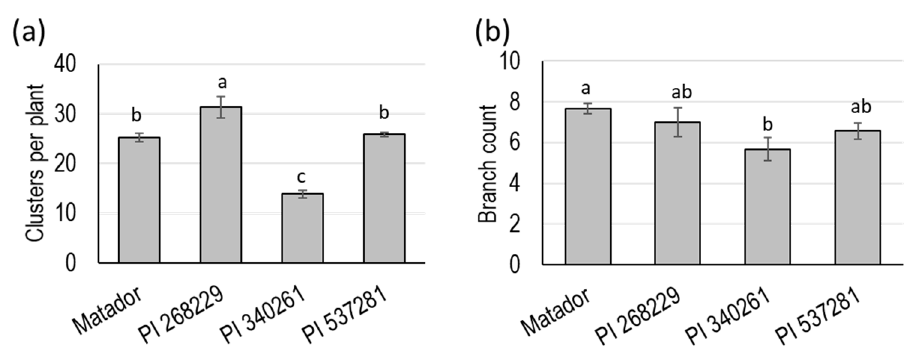
Figure 1. Field evaluation of four guar varieties for agronomic traits. ( a ) Clusters per plant. ( b ) Branch count. Different letters at the top of bars represent the statistical difference ( p ≤ 0.05) between means for different genotypes ( n = 3). Error bars represent standard